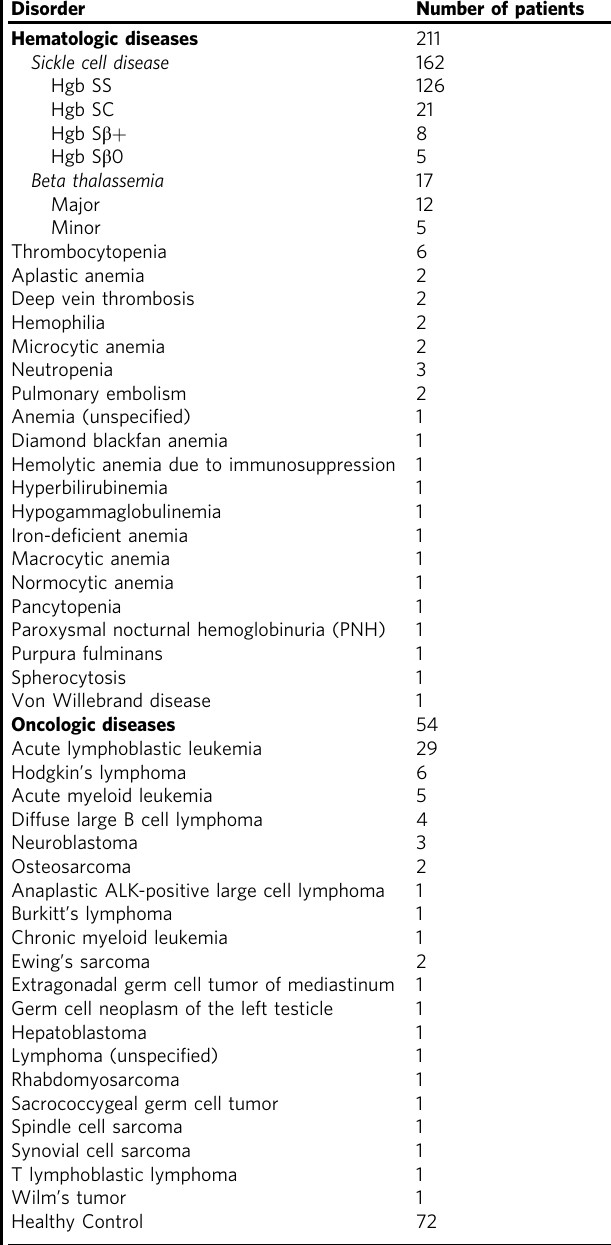
Table 2 Diagnosis pro fi le of subjects in clinical